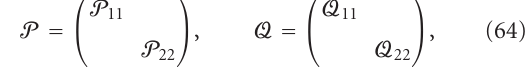
Algorithm 6 may lose some information. But Algorithm